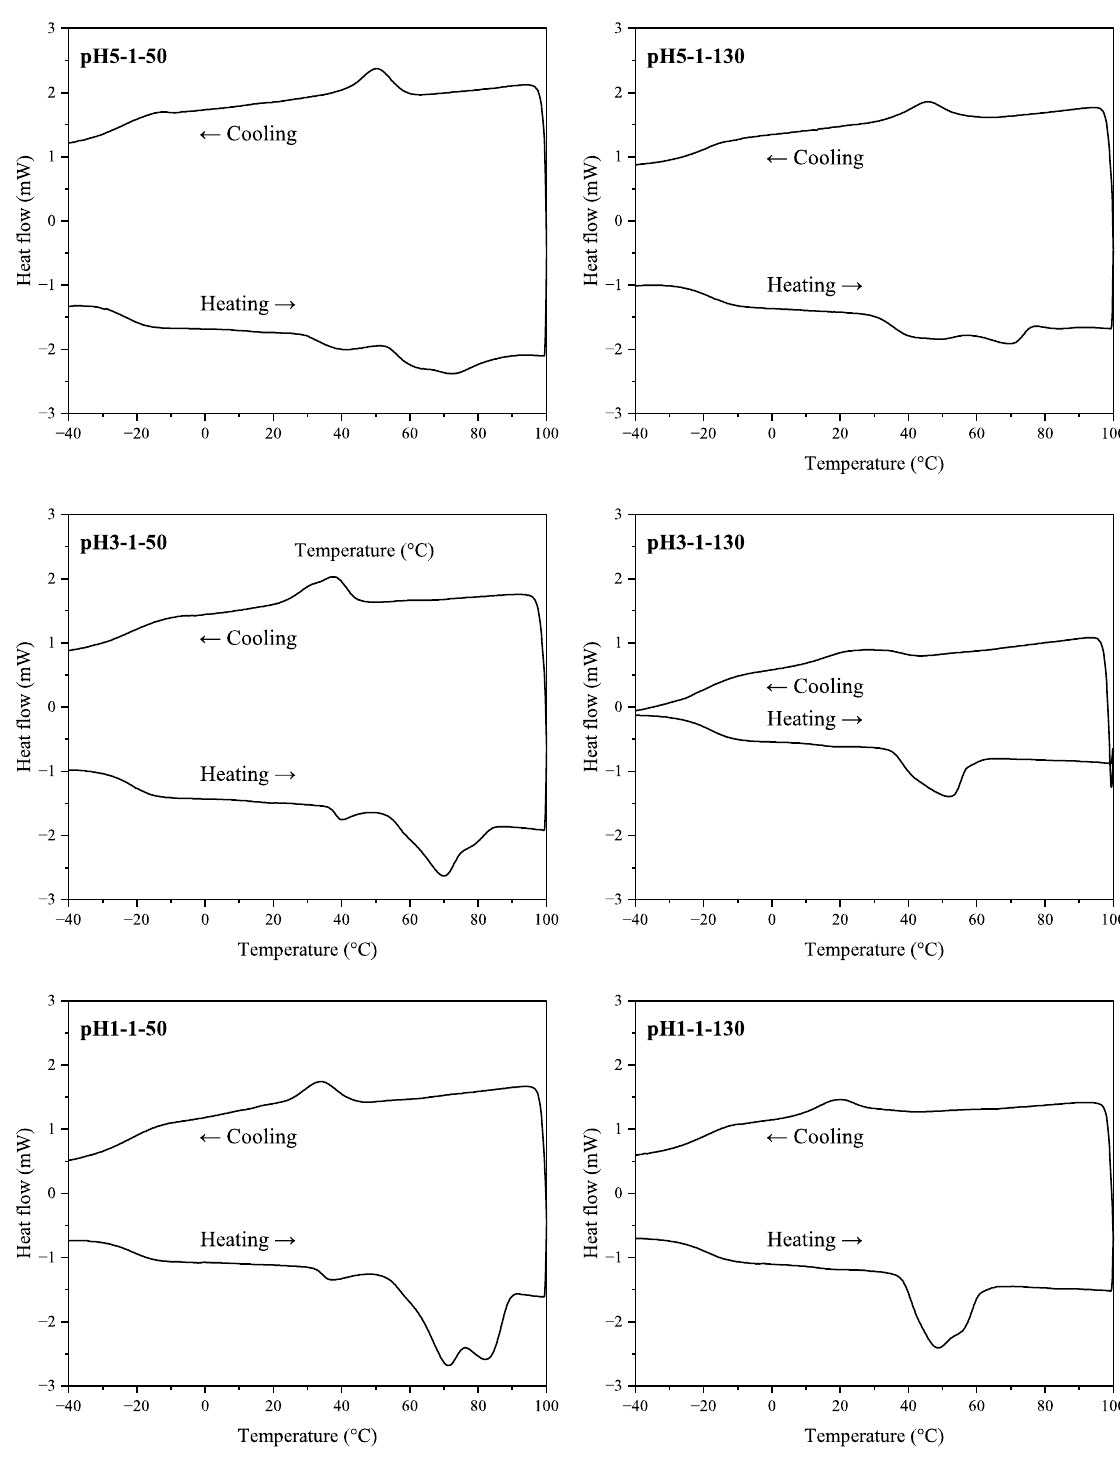
Figure 6. DSC thermograms of the SA samples.